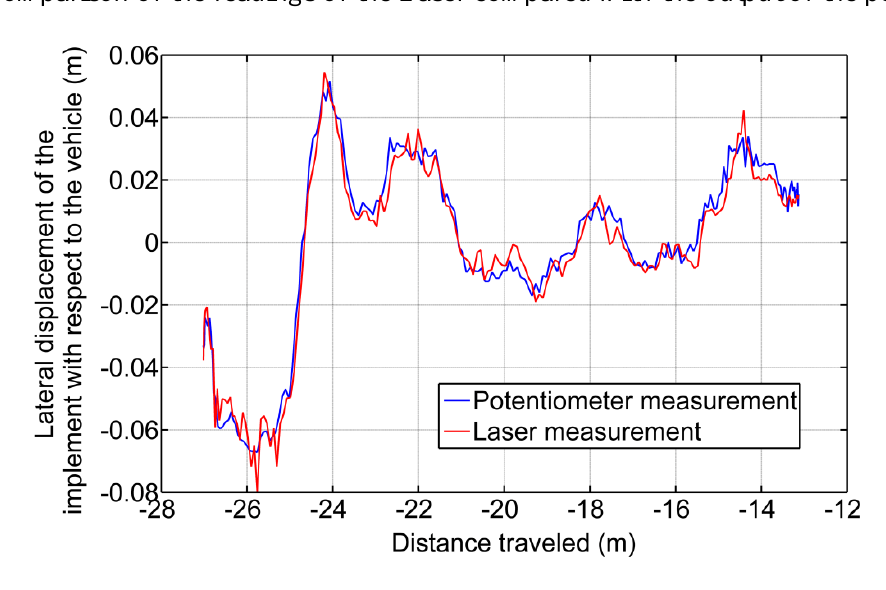
Figure 19. Schematic diagram of the PID controller in cascade configuration for controlling the lateral displacement of the implement with respect to the